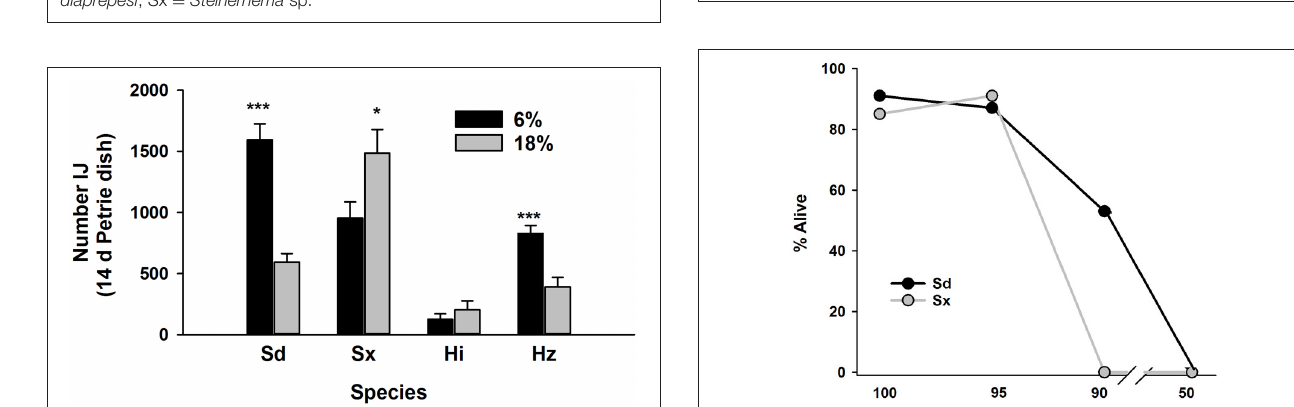
FIGURE 5 | Proportion of the total nematode population represented by Sd ( Steinernema diaprepesi ), or Sx ( Steinernema sp.) for three “generations” of nematodes maintained with Galleria mellonella larve in PVC columns filled with sand at field capacity (6% moisture) or saturated (18%). Significant differences between species within a generation from each moisture for each species denoted by ** P < 0.01 and ◦ P < 0.10.